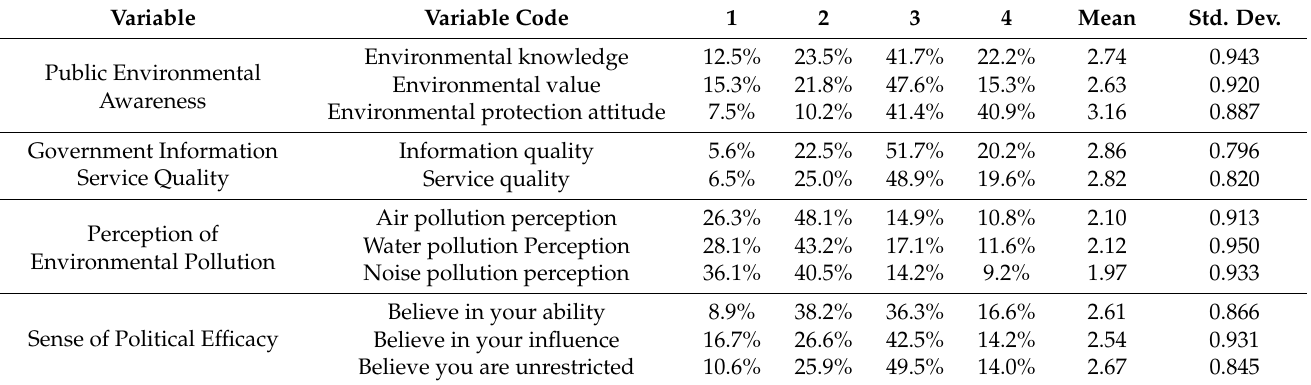
Table 2. The results of descriptive statistical